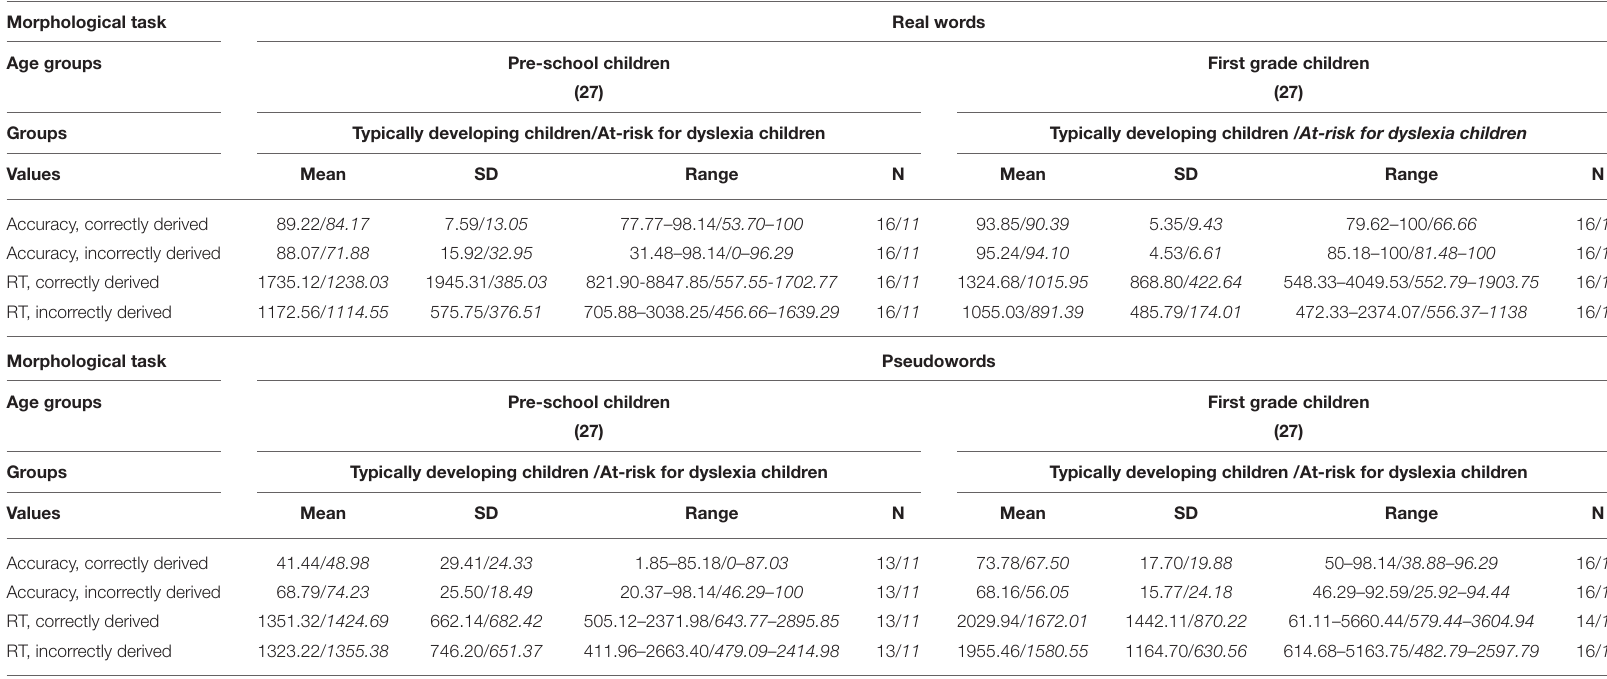
TABLE 3 | Accuracy and reaction times for real words and pseudowords (% for correct responses) for the participants’ behavioral performance during the MEG morphological task ( N = 27 pre-school children with and without risk, N = 27 first grade children with and without risk), separated by “/”). Morphological